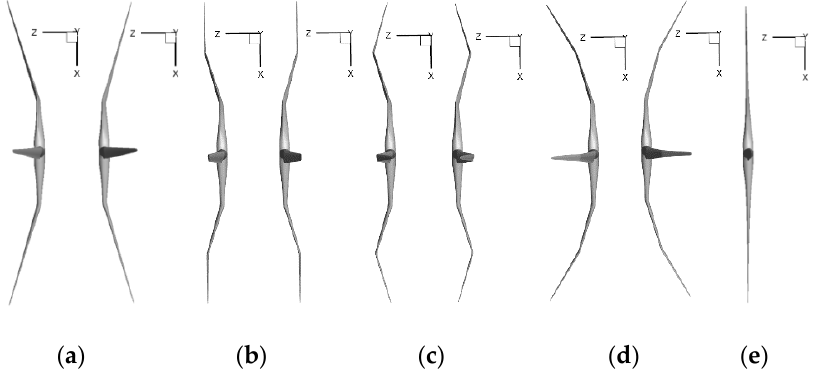
Figure 3. Down/upwind coned configurations with C cone = ±4 and T trans = 1/3: ( a ) C4 and C-4; ( b ) C4S0 and C-4S0; ( c ) C4S1 and C-4S1; ( d ) C4S2 and C-4S2; ( e ) straight baseline.